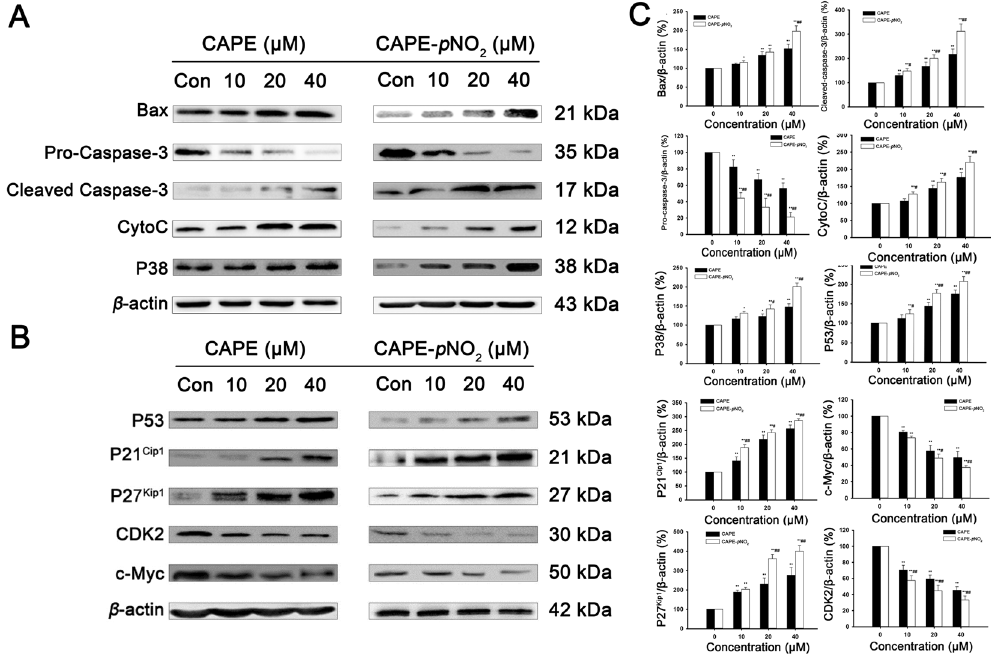
Figure 4. Regulation of apoptosis-related and cycle-related proteins by CAPE and CAPE- p NO 2 treatment in HT-29 cells. HT-29 cells were treated with CAPE and CAPE- p NO 2 at a dose of 0, 10, 20 or 40 μ mol/L for 48 h. (A) Apoptosis-related proteins in the P53 signalling pathway such as Bax, Pro-Caspase-3, Cleaved-Caspase-3, CytoC and P38 were determined by western blotting. (B) The cell cycle-related protein expression levels of P21 Cip1 , P27 Kip1 , P53, CDK2 and c-Myc were determined by western blotting. The blots were representative of three independent experiments. Data represented the means ± SD from three independent experiments, and error bars represented the STDEV (SD). * p < 0.05, ** p < 0.01: CAPE and CAPE- p NO 2 compared with the control. # p < 0.05, ## p < 0.01: CAPE- p NO 2 compared with CAPE at the same